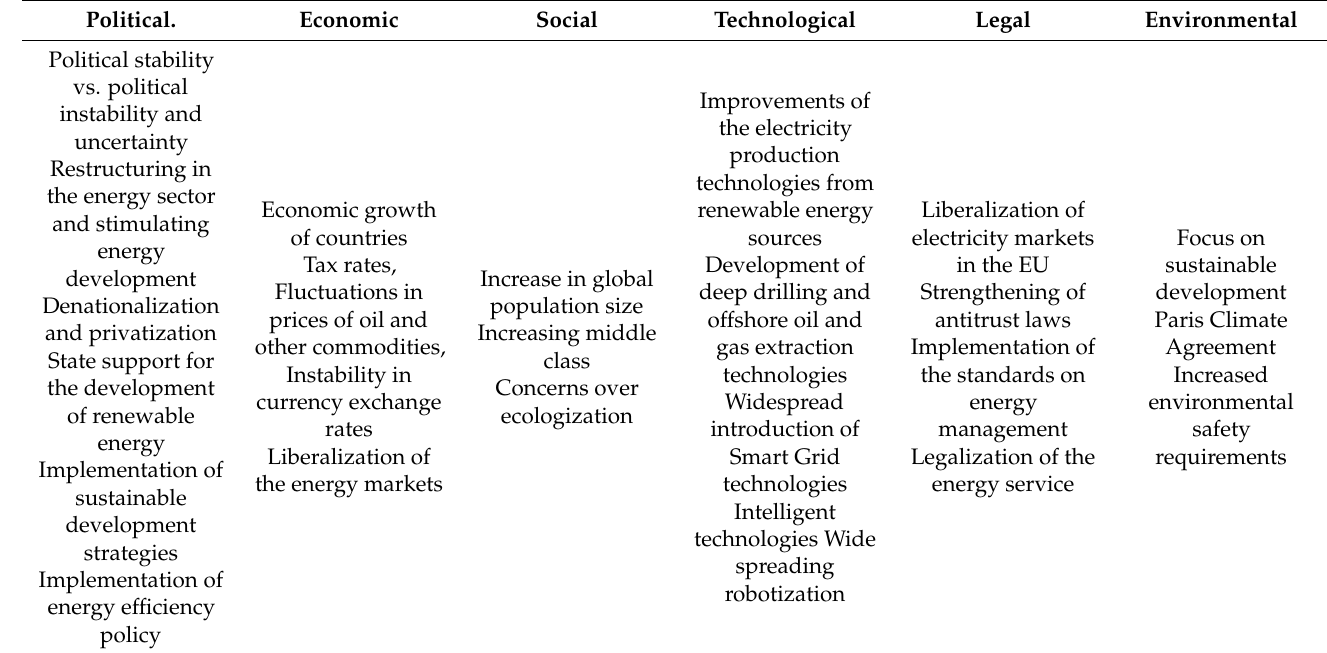
Table 3. Summary of the results of the PESTLE analysis of M&A in the energy industry.